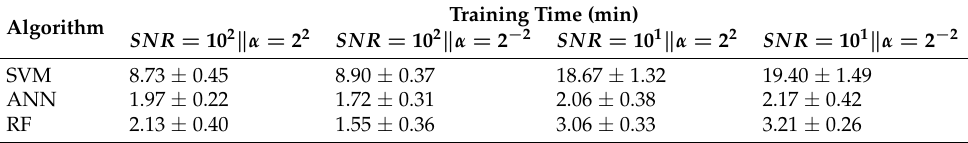
Table 5. Training times of the shallow learning-based